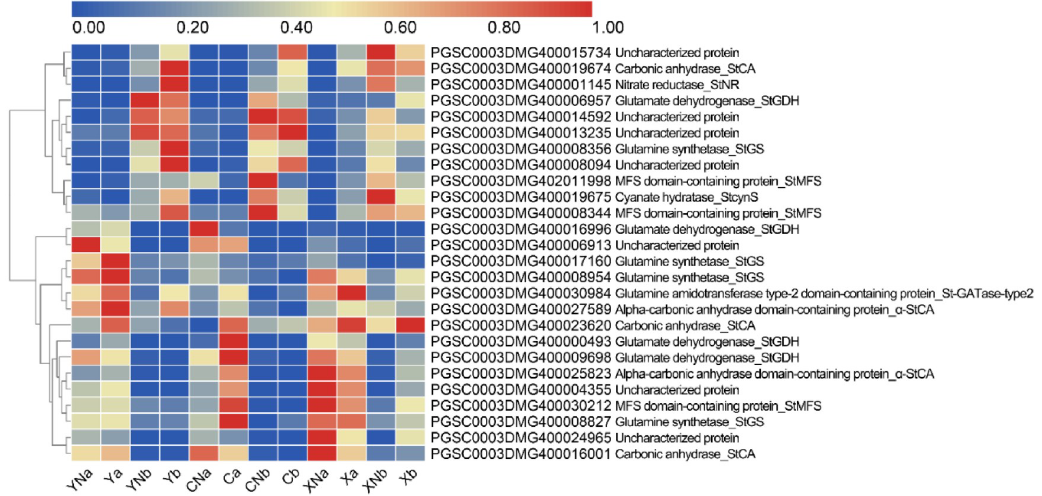
Fig 6. The expression profiles of the genes related to N metabolism in the leaf and root in response to N deficiency. A and B shows the expression profile of N metabolism-associated genes in the leaf and root tissue, respectively. The redder the color, the higher the amount of expression; each of the different color blocks on the left represents a class of transcript clusters with similar expression levels. A and b are short for leaf and root, respectively. Y, X and C indicate the cultivar of “Yanshu 4”, “Xiabodi” and “Chunshu 4”, respectively. N means treatment with N containing fertilizer (control). For example, YN and Y means “Yanshu 4” treated with N-containing and N-deficiency fertilizer, respectively. 322 kilojoules of food energy and is a rich source of vitamin B6 and vitamin C (https://ndb.nal. usda.gov/ndb/search/list). N is an essential element for potato cultivation. Different varieties